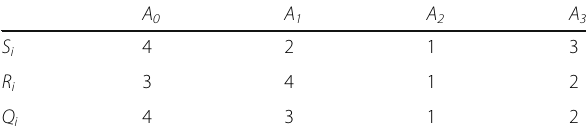
Table 8 Ranking of alternatives by S , R and Q